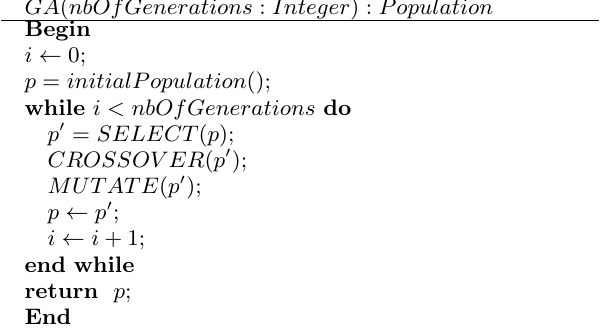
Figure 4: Individual